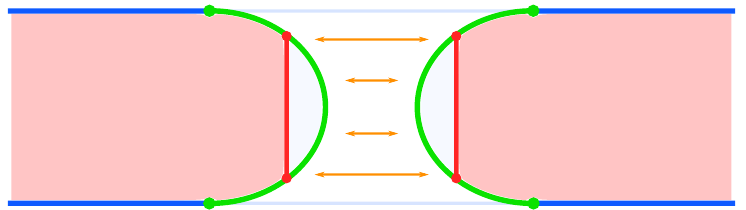
< 0 the competing bulk brane